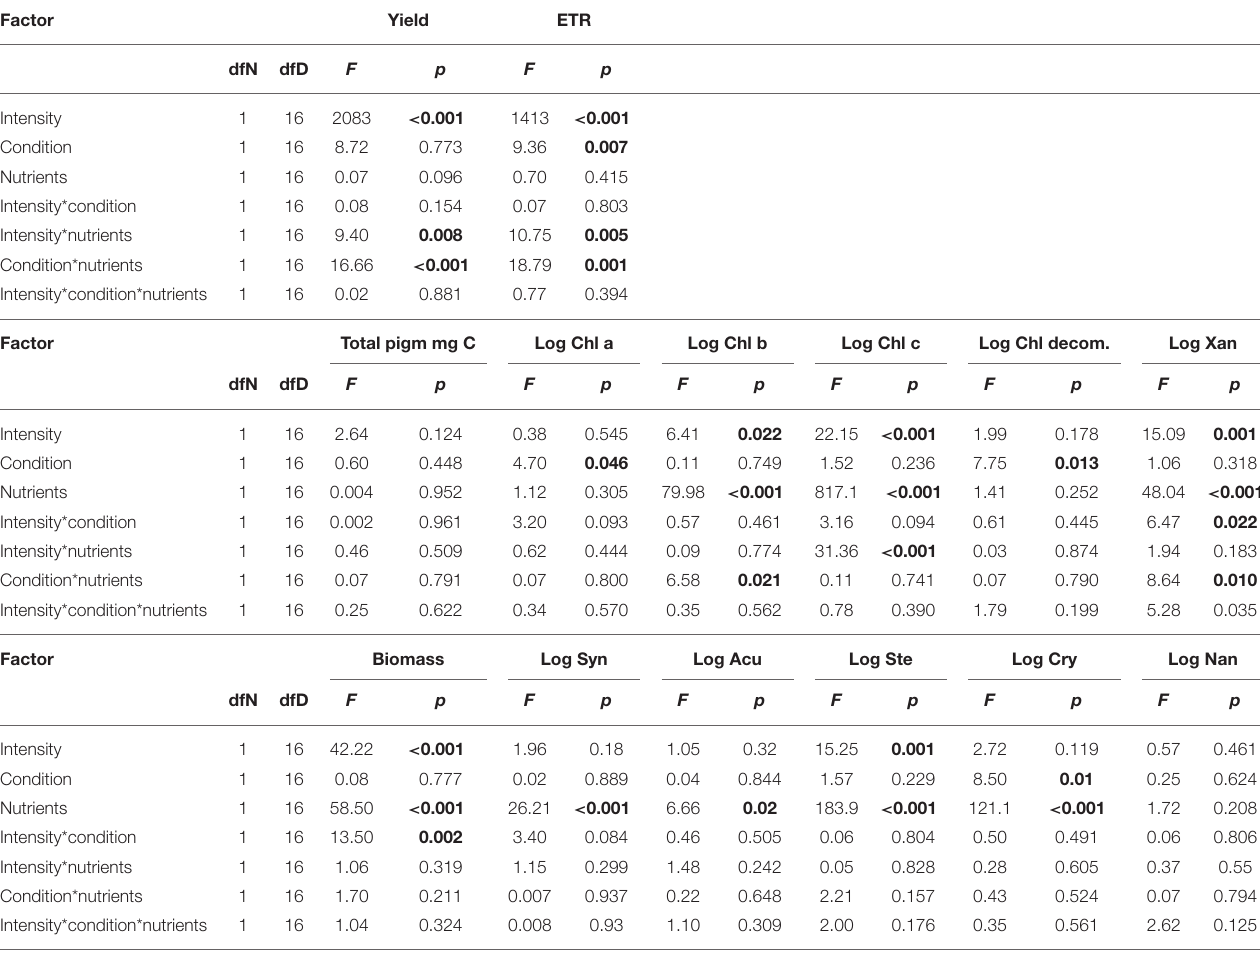
TABLE 1 | ANOVA table for all factors (light intensity, light condition, and nutrient condition) including interactive effects conducted for all response variables. Factor